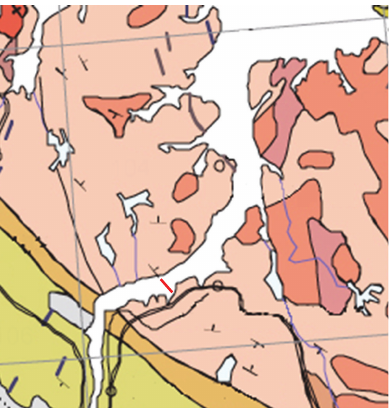
Figure 4: A fragment of the geological map of the Kola Penin- sula by Mitrofanov [18]. 92-leucogranites, granodiorites; 102- metavolcanics; 104-granodiorites, tonalites, plagiogranites; 106- micaceous, garnet-mica gneisses. Red line: the observation profile.